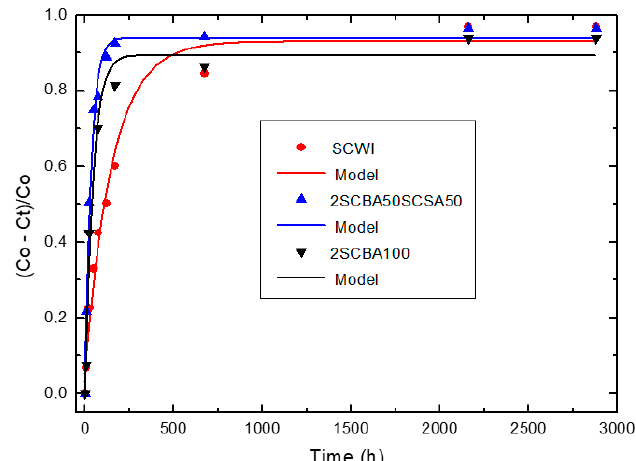
Figure 5. Relative loss of lime concentration versus reaction times for SCWI, 2SCBA50SCSA50 and 2SCBA100 ( Note : Black circle (experimental), solid line (model)).